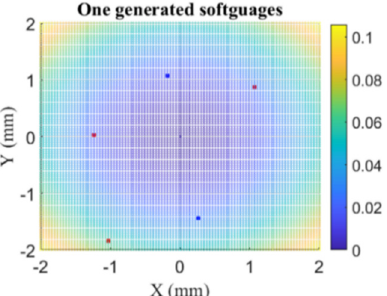
Figure 12. Illustration of the five contacting points (red and blue). Red indicates contacting points for which the form error is equal to e . Blue indicates form error equals to − e.